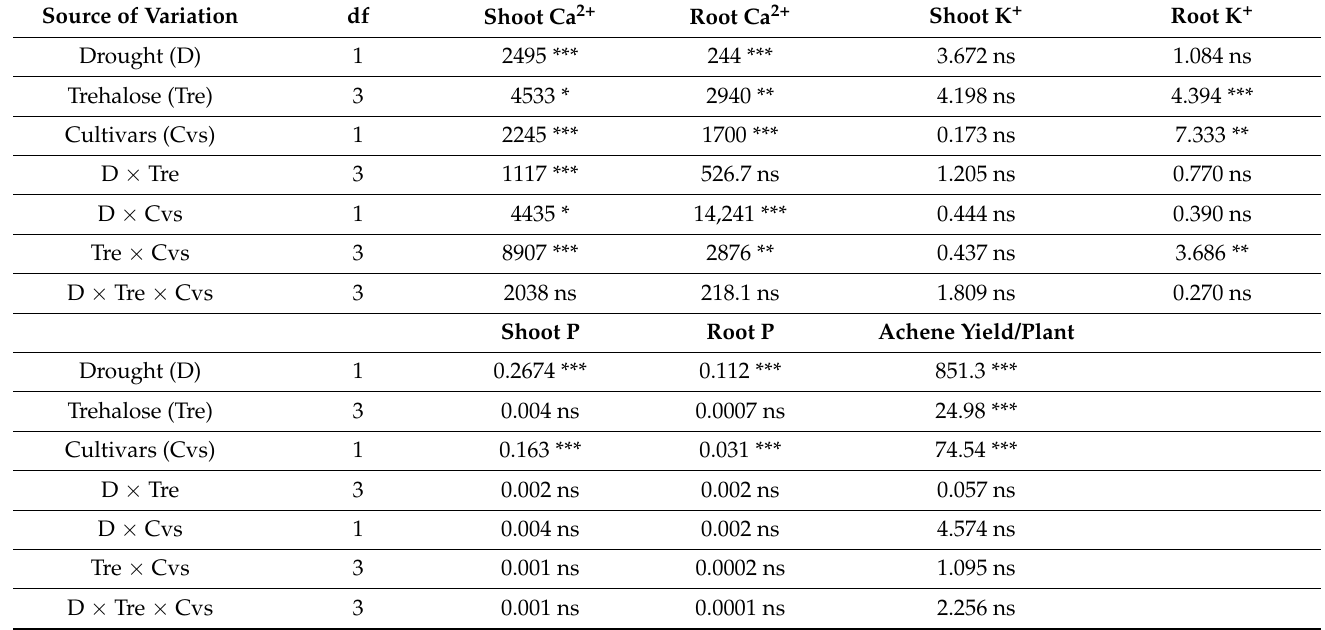
Table 2. Mean square data for mineral nutrients and achene yield attributes of sunflower ( Helianthus annuus ) plants subjected to varying (0, 10, 20, and 30 mM) levels of trehalose under drought